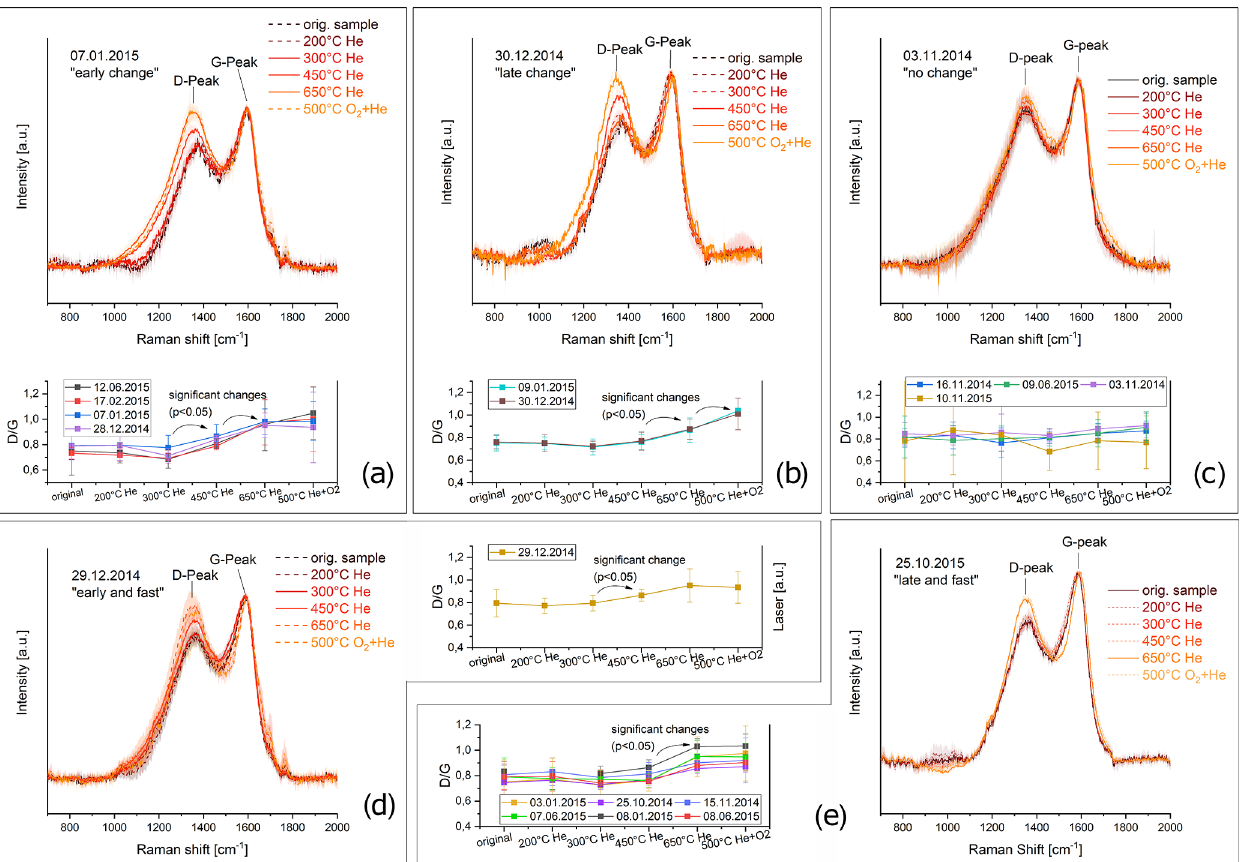
Figure 5. Examples of Raman spectra for of heated and unheated filter samples assigned to the categories “early structural change” (a) , “late structural change” (b) , “no structural change” (c) “early and fast structural change” (d) and “late and fast structural change” (e) . Error bars are shown as shaded areas. The changes of D/G ratio with heating temperature are shown for all samples assigned to the respective category in an additional image. Arrows indicate the temperature levels where significant changes were identified according to a t test ( α =